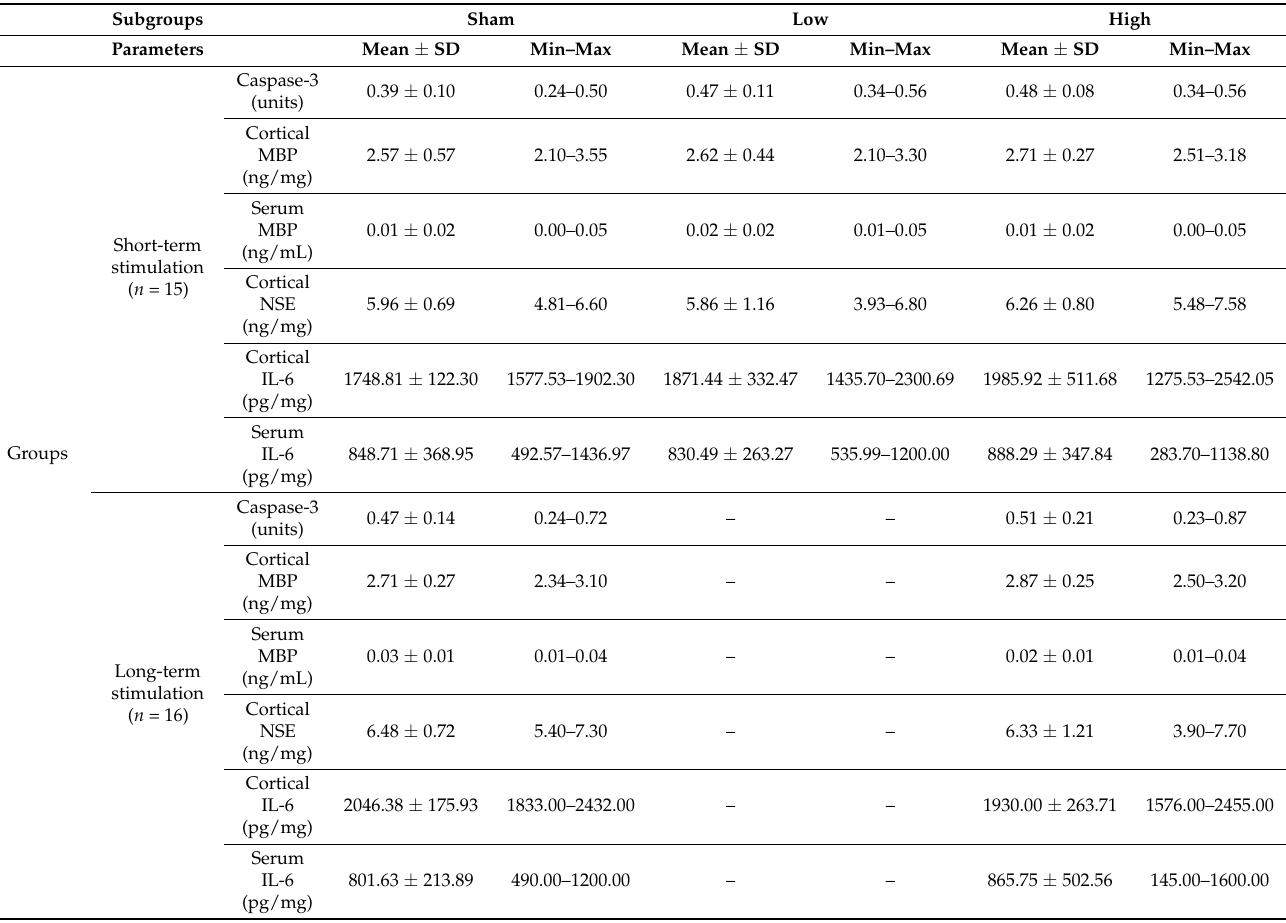
Table 1. Descriptive statistics of biomarkers during short- and long-term stimulation ( n = 31).